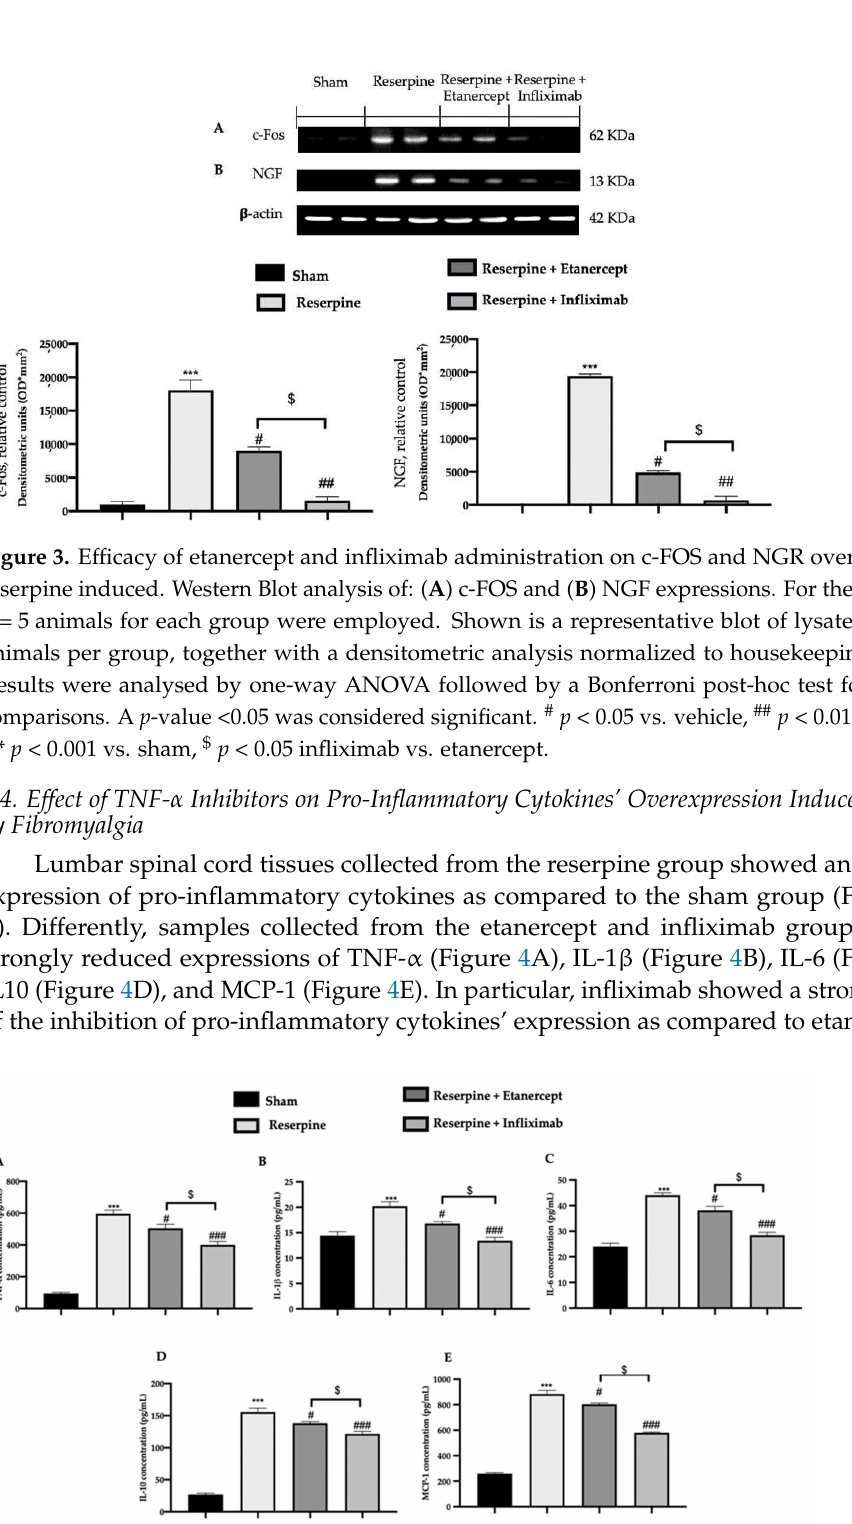
Figure 4. Efficacy of etanercept and infliximab administration on cytokines overexpression reserpine induced. ELISA analysis of: ( A ) TNF- α , ( B ) IL-1 β , ( C ) IL-6, ( D ) IL10 and ( E ) MCP-1 expressions. For these analyses n = 5 animals fror each group were employed. Results were analysed one-way ANOVA followed by a Bonferroni post-hoc test for multiple comparisons. A p -value <0.05 was considered significant. *** p < 0.001 vs. sham. # p < 0.05 vs. vehicle, ### p < 0.001 vs. vehicle, $ p < 0.05 infliximab vs.